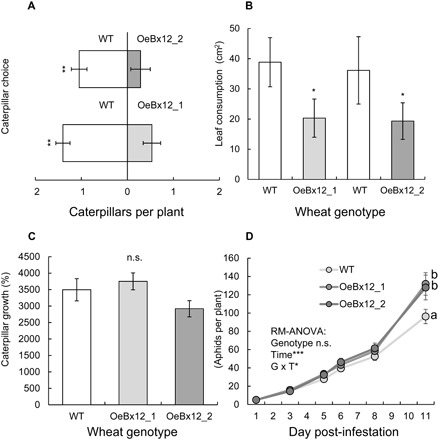
DIMBOA-Glc O-methylation changes aphid and caterpillar resistance in opposite directions.(A) Preference of S. littoralis caterpillars for WT or ZmBx12-overexpressing plants (n = 15 to 21). (B) Leaf damage in a choice situation (n = 8). Asterisks indicate significant differences between lines (one-sample t tests on pairwise differences, *P < 0.05, **P < 0.01, ***P < 0.001). (C) Caterpillar growth in a no-choice experiment. (D) S. avenae aphid reproduction on different lines. Different letters indicate differences between plant lines (repeated-measures ANOVA followed by Holm-Sidak post hoc tests, P < 0.05). Significance levels for repeated-measure ANOVA factors are shown. n.s., not significant.